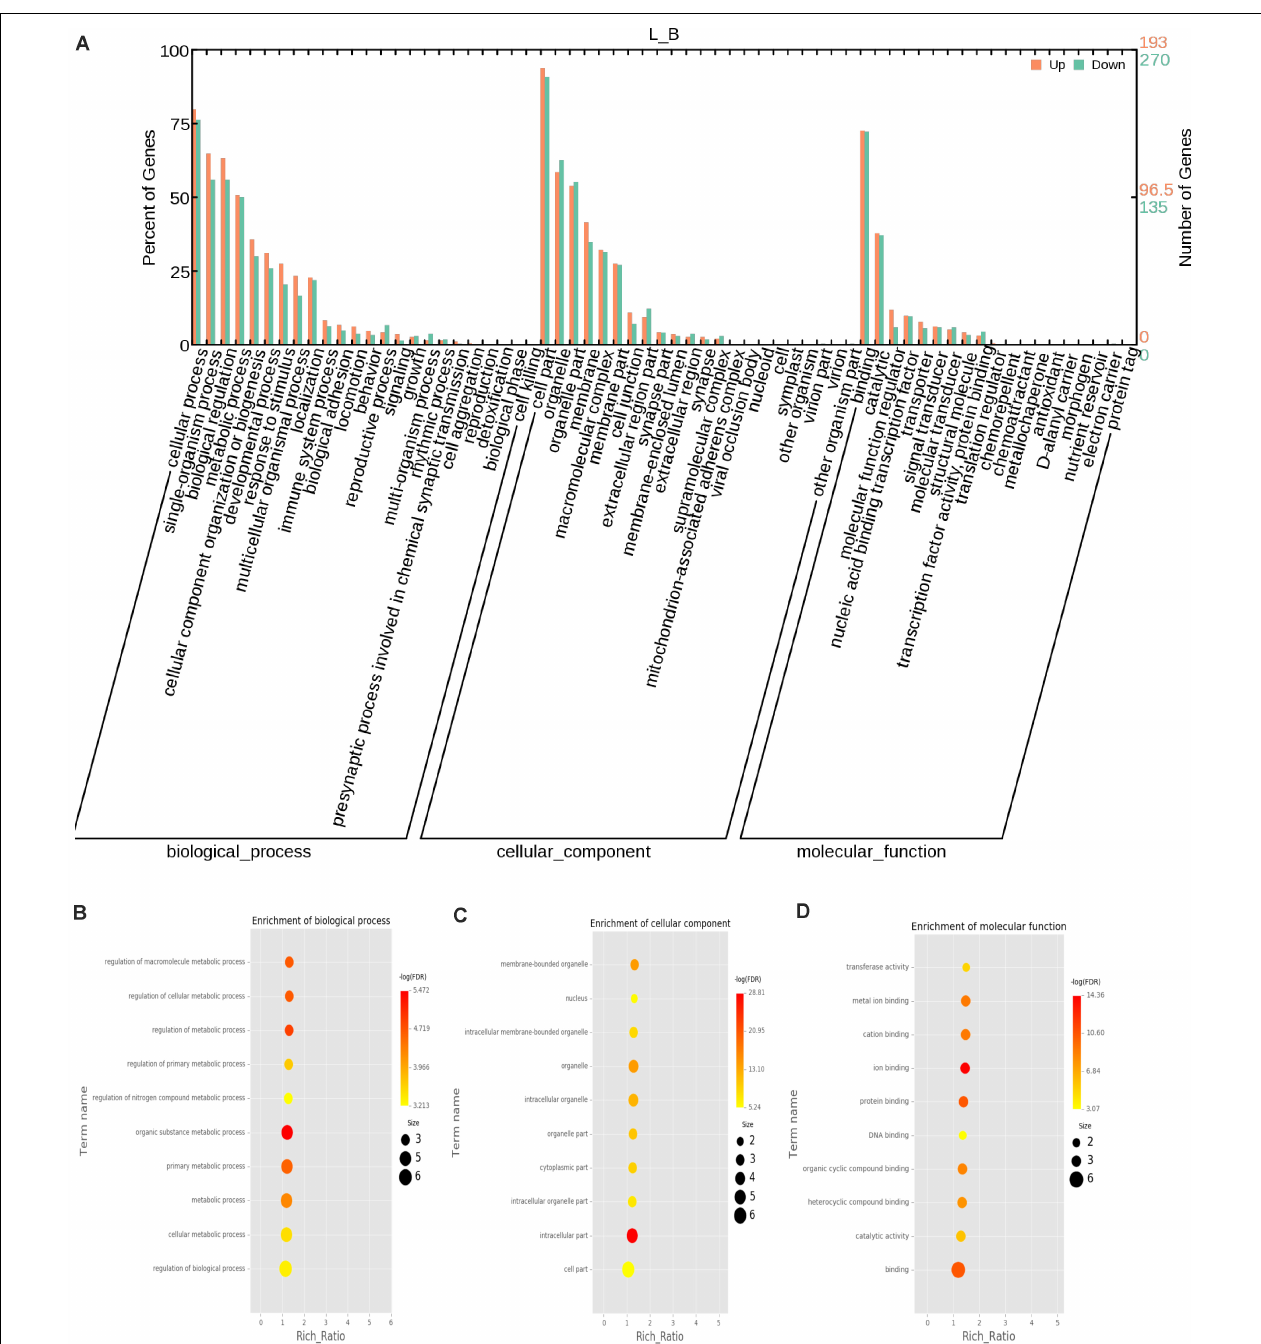
FIGURE 4 | GO annotation of differential circRNAs and enrichment analysis. (A) GO annotation of the parental genes of DE circRNAs. The abscissa is the ontology classification, and the ordinate is the proportion of genes annotated to this term among all annotated genes; (B–D) Q -value enrichment map of single group GO entries. Each point represents the estimated enrichment degree of the corresponding GO term, and the closer the color is to red, the higher the enrichment degree. The size of each point indicates the number of genes enriched in the GO term, and the larger the point is, the more genes enriched in the GO term, and vice versa.